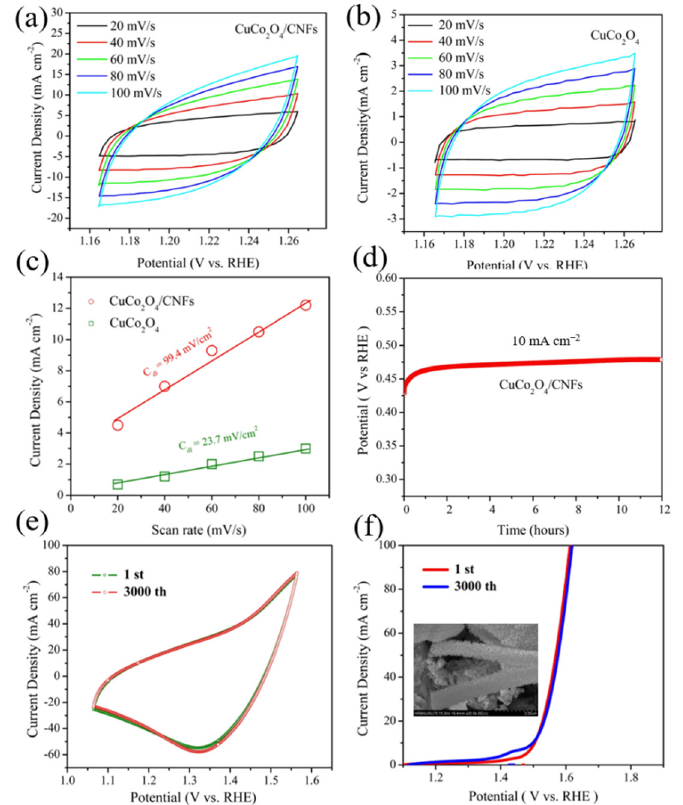
Figure 7. ( a ) The double-layer capacitance of the CuCo 2 O 4 @CNFs, ( b ) the double-layer capacitance of the CuCo 2 O 4 @CNFs, ( c ) the electrochemical double-layered capacitance measurements linear fitting of the capacitive currents of the catalysts against the scan rate to fit a liner regression, ( d ) stability of the CuCo 2 O 4 @CNFs electrode at 10 mA cm − 2 , ( e ) CV curves of CuCo 2 O 4 @CNFs electrode before and after 3000 cycles at the scan rate of 100 mV s − 1 in the range of 1.06–1.56 V vs. RHE, ( f ) polarization curves of CuCo 2 O 4 @CNFs electrode and CuCo 2 O 4 electrode before and after 3000 cycles at the scan rate of 5 mV s − 1 . SEM image of CuCo 2 O 4 @CNFs electrode after 3000 cycles (inset).